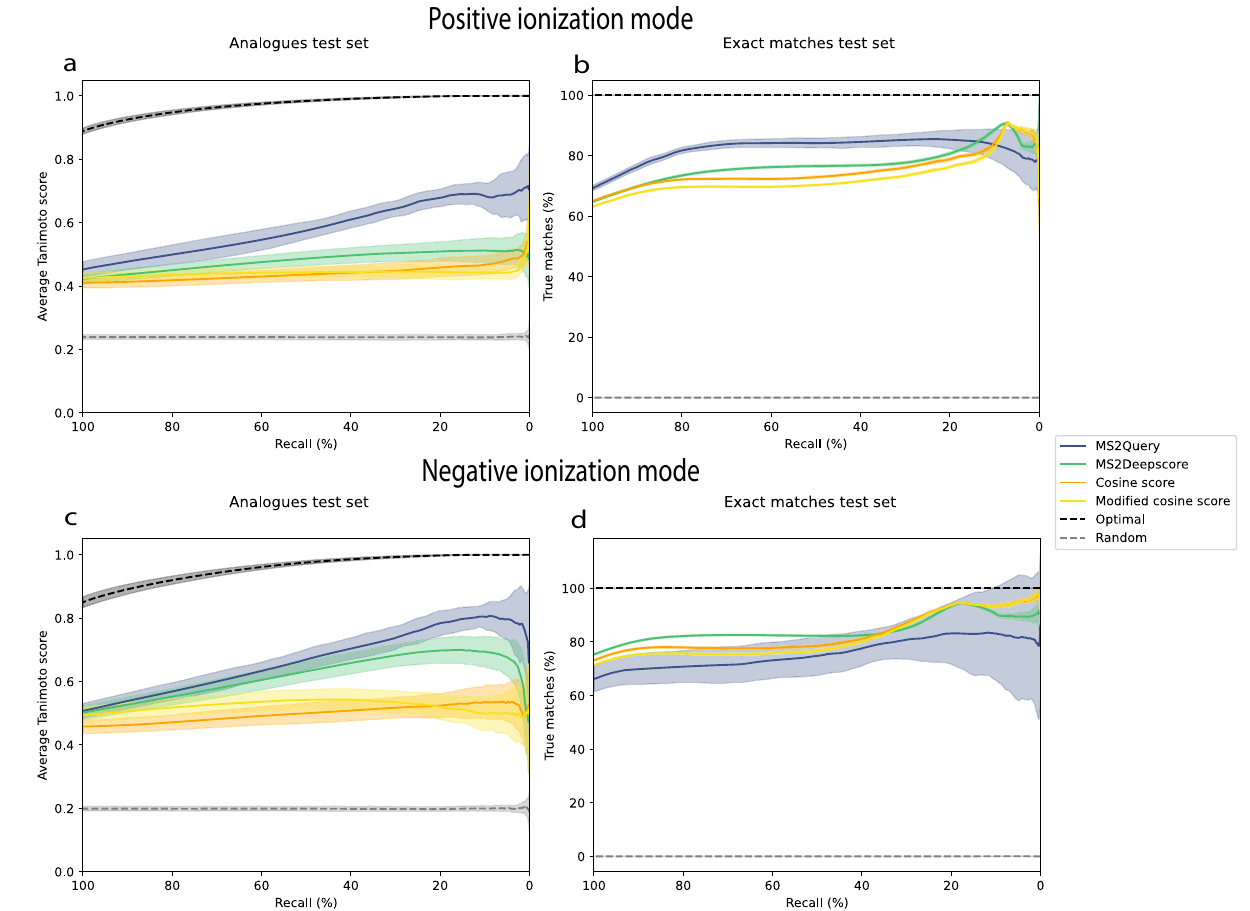
Fig. 2 | MS2Query benchmarking results. MS2Query is more accurate for fi nding analoguesthanusingMS2Deepscoreormodi fi edcosinescoreandismoreaccurate at predicting exact matches in positive mode at high recall than using MS2Deep- score, the cosine score or the modi fi ed cosine score. The threshold for MS2Query, MS2Deepscore, cosine and modi fi ed cosine is varied, resulting in different recalls. The random results showthe results ifrandom matcheswouldbeselectedand the optimalresultsshowtheperformanceifthebeststructuralmatchinthelibrarywas selected. Results of 20-fold cross-validation are shown. The mean of these 20 test sets areshownand the standard deviationishighlighted.Sourcedataareprovided as a Source Data fi le. a The ‘ analogues test set ’ is used with spectra that have